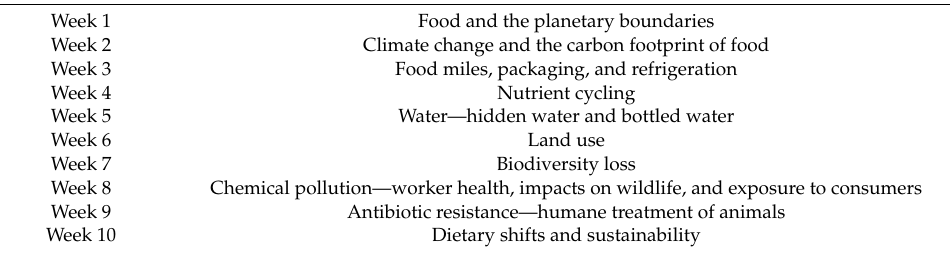
Table 1. Overview of Foodprint seminar course